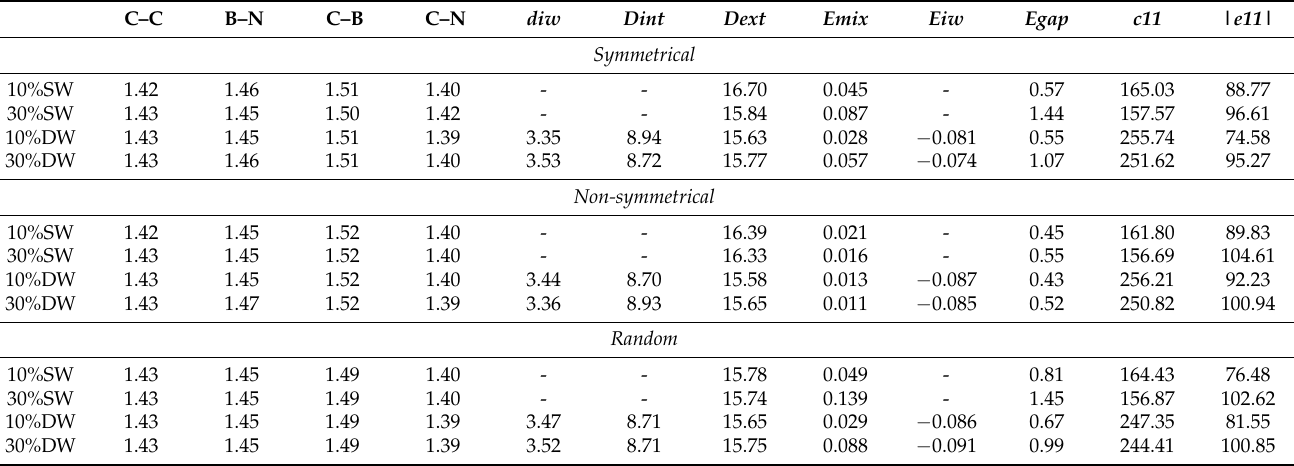
Table 2. Structural properties (in Å) and energetics (in eV) at the PBE0 level of single (20,0) and double- wall (11,0)@(20,0) zigzag carbon nanotubes with different BN doping percentages and patterns. Bond length (C–C, B–N, C–B, and C–N), inter-wall distance ( diw ), internal and external diameters (Dint and Dext), formation and inter-wall energies per atom ( Emix, Eiw ), band gap energy ( Egap ), elastic ( c11 , Hartree), and piezoelectric constants (| e11 |,